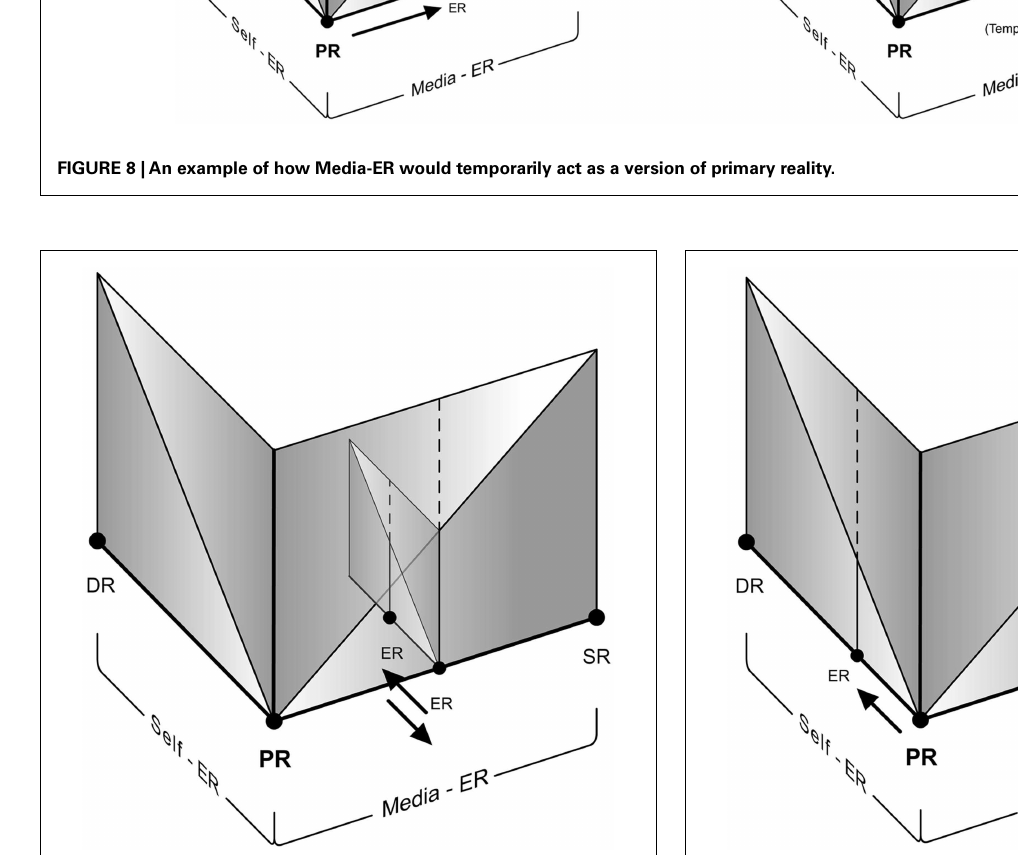
FIGURE 10 |The usual case of presence shift from primary reality to